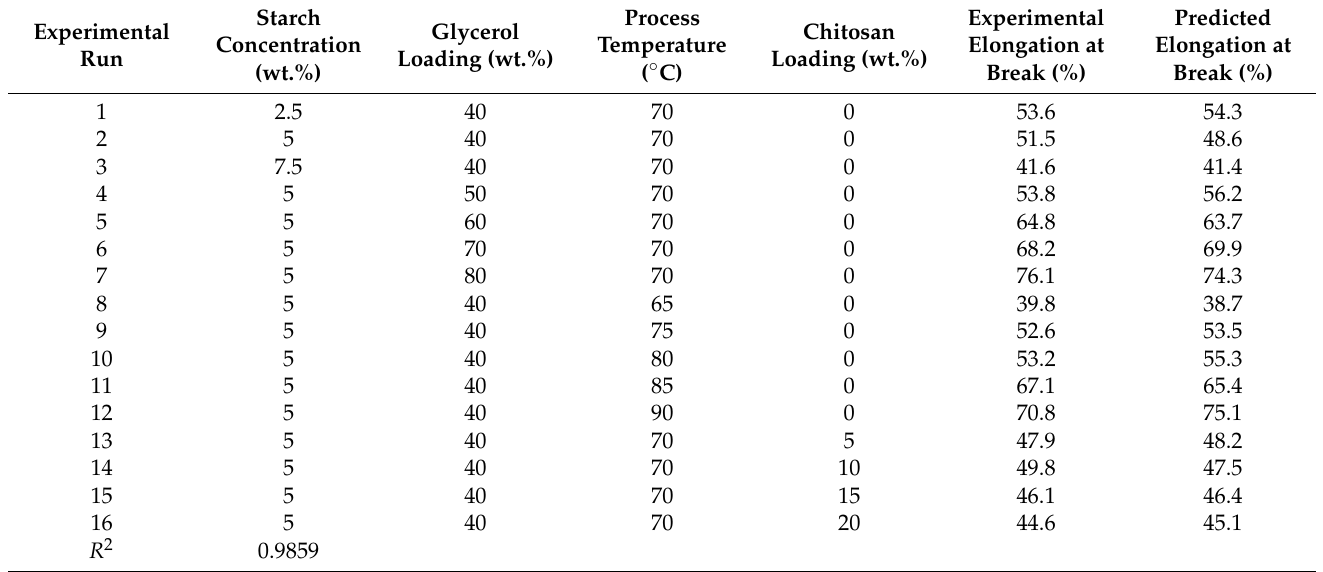
Table 3. Comparison of the experimental elongation at break and predicted elongation at break by ANN